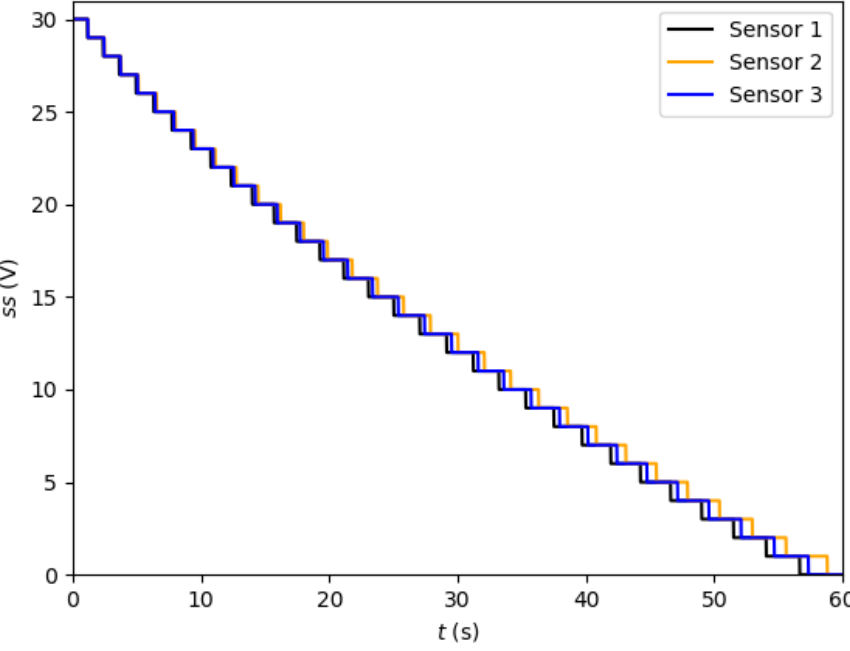
Figure 33. RBS signals, feedback with complete regulation law, case